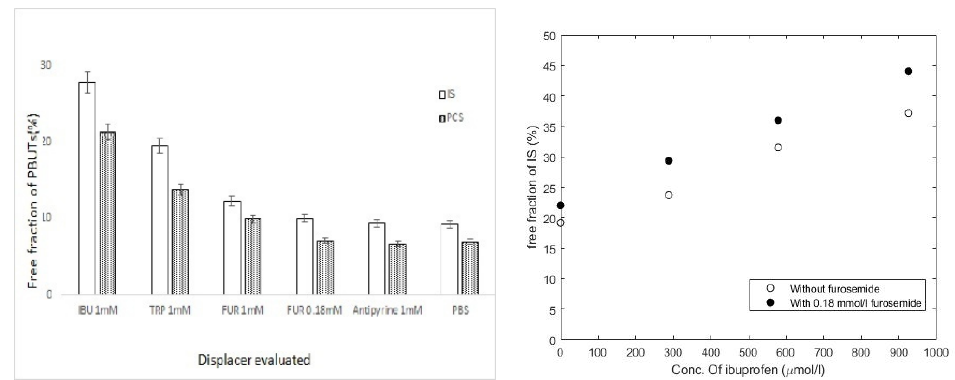
Figure 10. IS and PCS displacement in uremic plasma by furosemide (FUR), tryptophan (TRP), and IBU ( left ), and the IBU and FUR dosage effect in IS displacement ( right ), both determined in static RED assays [93].